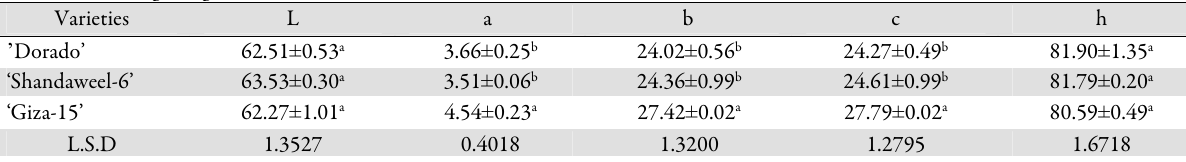
Table 2. Color of sorghum grains Varieties L Dorado’ ’